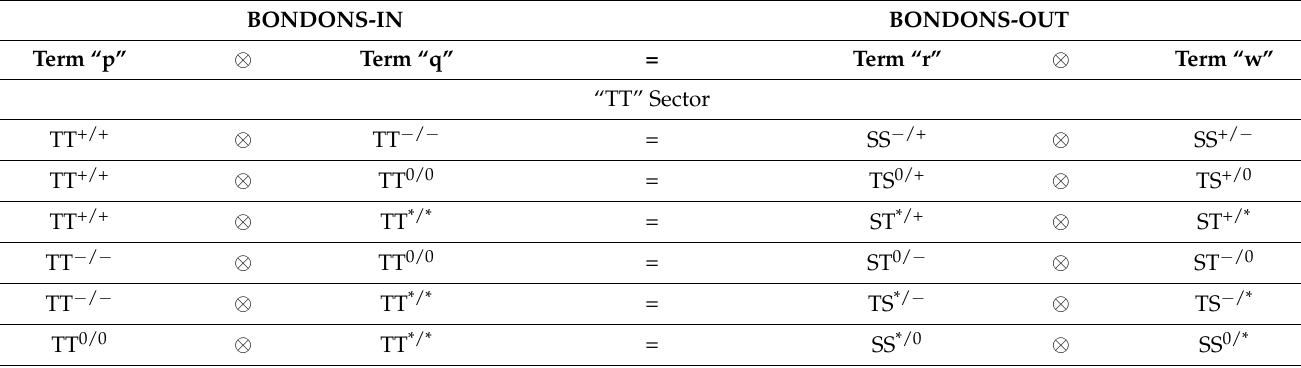
Table 2. Bondonic contractions along the reaction coordinates, while involving the left and right creation–annihilation life-lines for all combinations specific to each “ past-future ” triplet and singlet total spin sectors of corresponding Feynman’s diagrams for the “present” in and out valence electrons in a generic chemical bonding and reaction mechanism; special emphasis by detailed Feynman bondonic diagrammatic contraction is given for those interactions involving/resulting in TT */* product, for each bondonic sector, as such terms are currently associated with the electronic affinity bonding/bondonic contribution (see text for further details and Figure 1 for more on symbolic and diagrammatic representation of